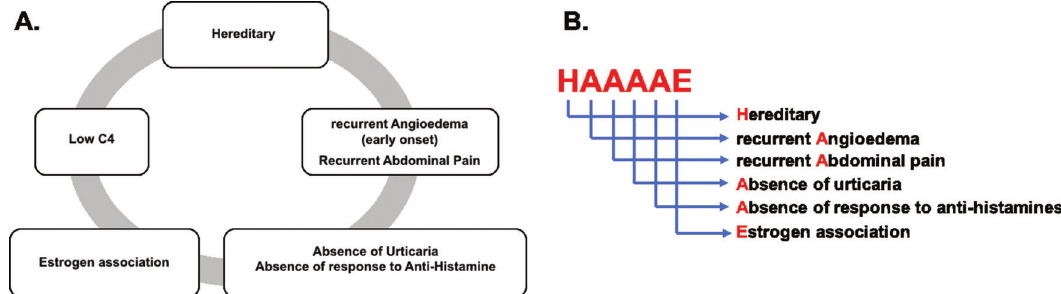
Figure 2 - A: Warning Signs. B: HAAAAE for Heredity, recurrent Angioedema, recurrent Abdominal pain, Absence of urticaria, Absence of response to antihistamines and association with